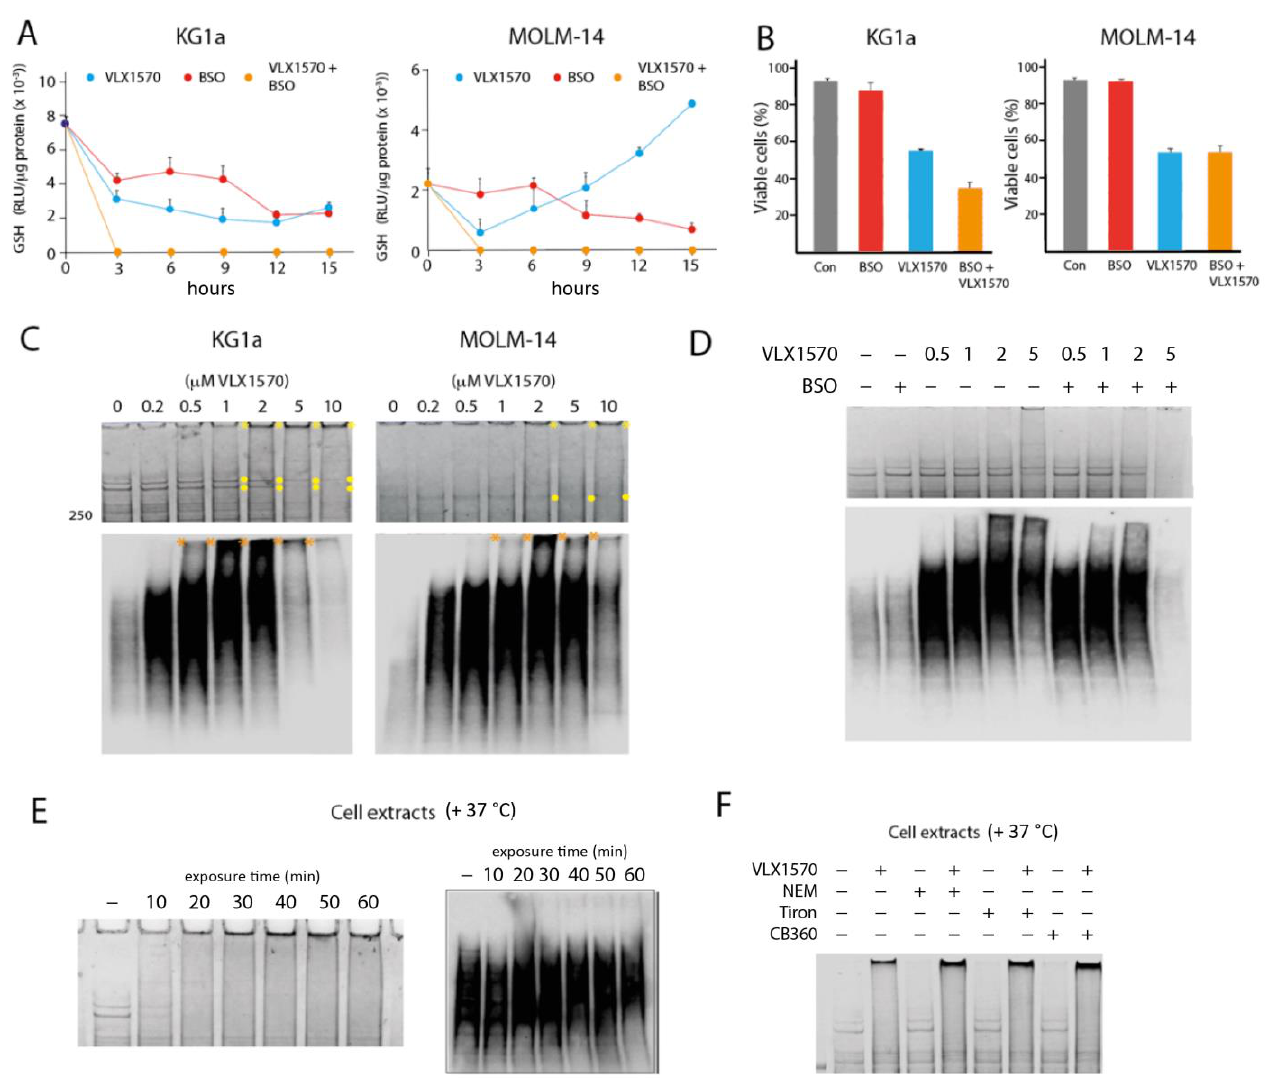
Figure 5. Depletion of reduced glutathione (GSH) and induction of high-molecular-weight complexes in AML cells. ( A ) GSH levels in AML cells after different times of exposure to 0.35 μM VLX1570 and/or 10 μM BSO. Means and SDs from one representative experiment are shown; ( B ) fraction viable cells determined by the AO/PI method after treatment with VLX1570 and/or BSO. Means and SDs from one representative experiment are shown; ( C ) (top) high molecular weight (HMW) region of Coomassie BB-stained SDS-PAGE gels loaded with extracts from cells exposed for 4 h to different concentrations of VLX1570, (bottom) immunoblots of extracts from VXL1570-exposed cells probed with an antibody to K48- linked polyubiquitin, note the distribution of high molecular weight bands marked with yellow and orange dots; ( D ) effect of 10 μM BSO on the formation of HMW complexes and loss of HMW proteins in KG1a cells exposed to 0.5, 1, 2, and 5 μM VLX1570; ( E ) KG1a cell extracts were exposed to 1 μM VLX1570 for increasing times at 37 °C and analyzed by SDS- PAGE; (left): gel stained with Coomassie blue, (right): immunoblot probed with an antibody to K48-linked polyubiquitin; and ( F ) effect of pretreatment of cell extracts with 20 μM NEM, 100 μM Tiron, or the Michael-acceptor-containing com- pound CB360 (30 μM) [40] on the formation of HMW complexes. Plots ( A , B ) show the average of three replicates, and error bars represent one standard deviation.